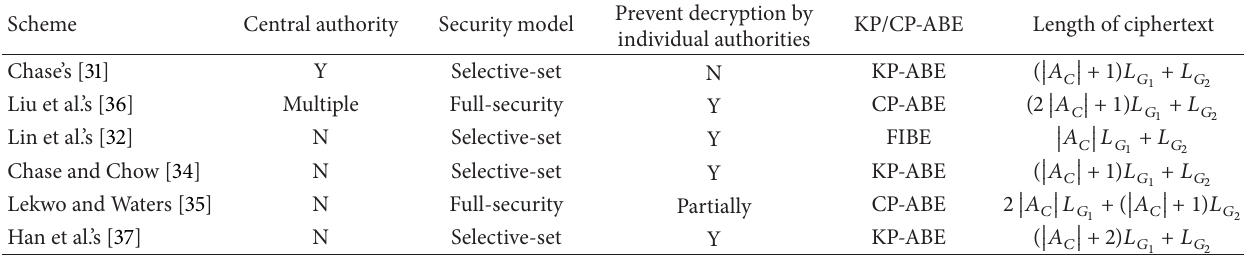
Table 4: Comparison of central authority, security model, and type and length of ciphertext.